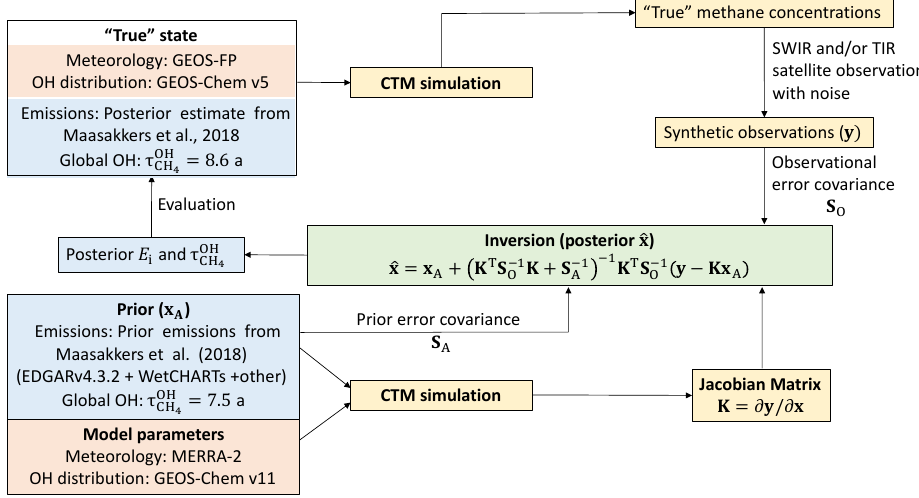
Figure 2. Observing system simulation experiment (OSSE) framework to test the ability of SWIR and TIR satellite observations of atmo- spheric methane to simultaneously constrain methane emission rates ( E i ) and the global mean tropospheric OH concentration expressed as methane lifetime against oxidation by tropospheric OH